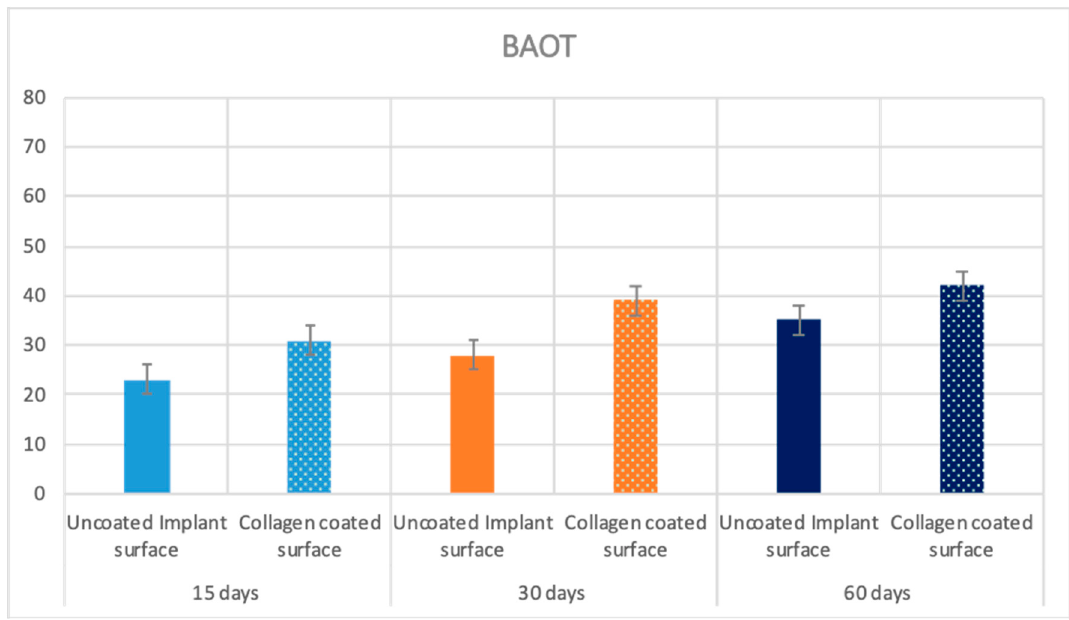
Figure 11. Means and SD of the measured BAOT ratios at 15, 30 and 60 days. Y axis is BAOT implant contact expressed in %.